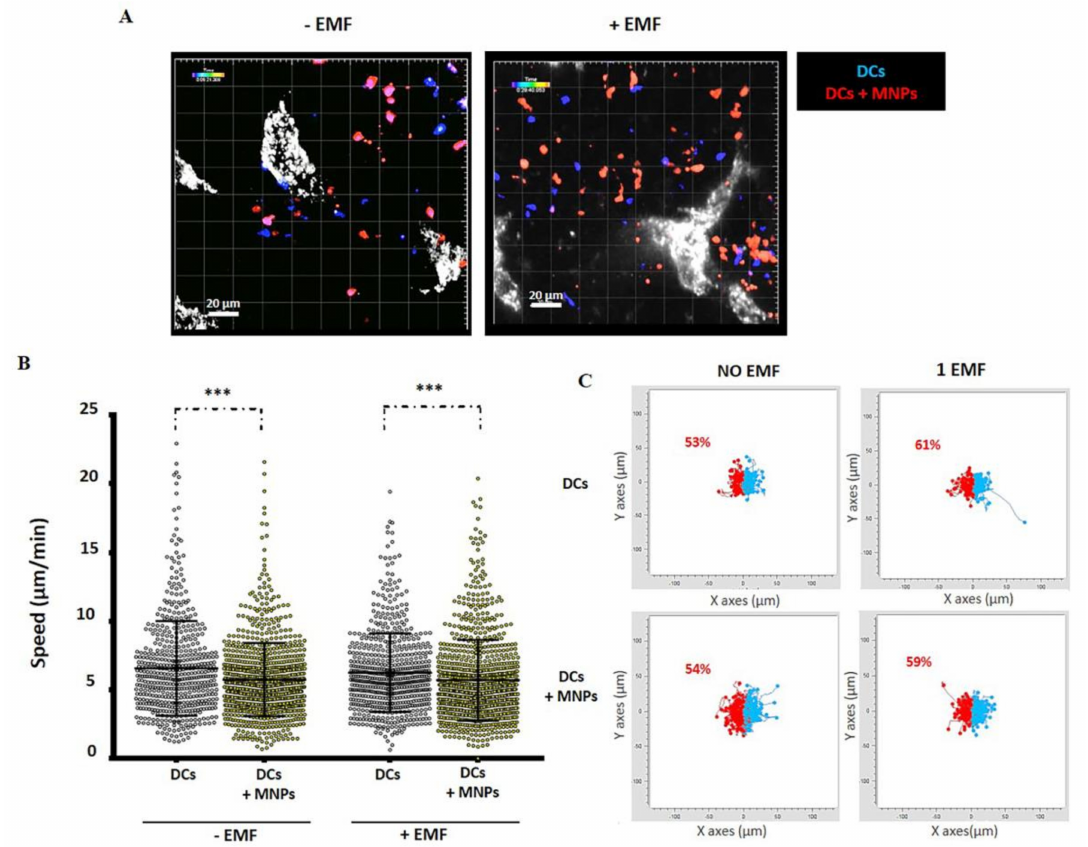
Figure6. In vivobehaviorofMNP-loadedorunloadedmurineDCsinthepoplitealLNinthepresenceor absence of an EMF. ( A ) Representative captures of multiphoton microscopy movies obtained in presence or absence of EMF (blue: MNP-free DCs, red: MNP-associated DCs, gray: high endothelial venules (HEVs)). ( B ) Quantification of cell speed after movie analysis using Imaris software. The results shown (mean ± SD) are representative of two–three independent experiments. Student’s t-test, *** p < 0.001. ( C ) Paths followed by MNP-treated or untreated DCs inside the LN during the multiphoton microscopy assays in the absence or presence of EMF placed on the left (overall DC displacement to the left in red; to the right in blue), analyzed with the software provided by Ibidi (Chemotaxis and Migration tool). The methodology and ethic committee permits for these experiments are detailed in